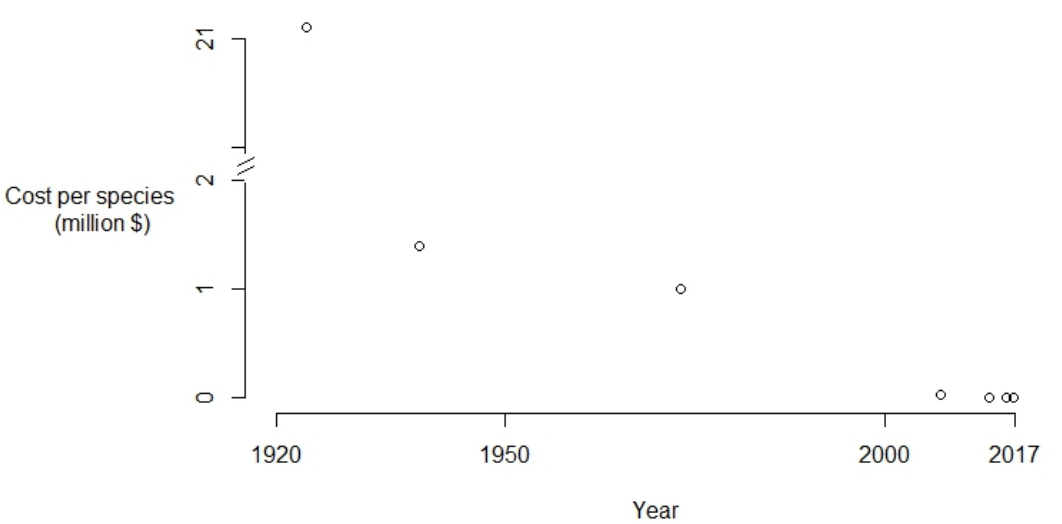
Figure 2. Costs involved in the development and initial implementation of biological control actions for invasive cactus species. US$ are adjusted for 2018 values. Each point corresponds to a different biological control campaign, in chronological order: Opuntia stricta in Australia [82], O. aurantiaca [84], Harrisia martinii [90], Cylindropuntia fulgida var. fulgida [91], O. humifusa [90], C. fulgida var. mamillata [91] and H. pomanensis [90] in South Africa.